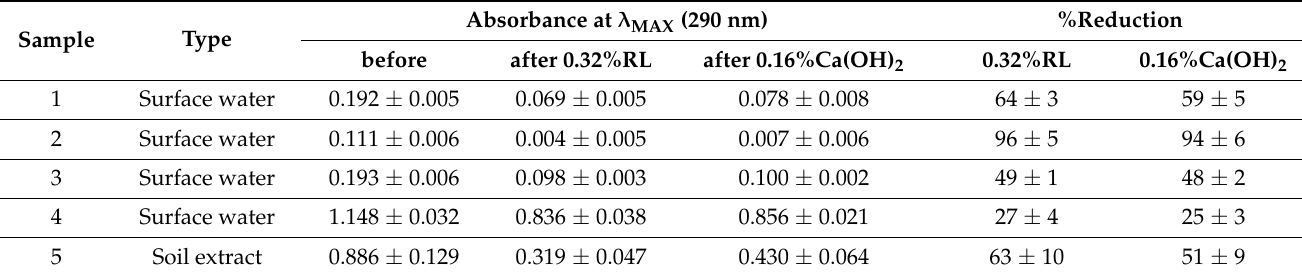
Table 2. The absorbance of aqueous suspension samples before and after filtering with the prepared filters.